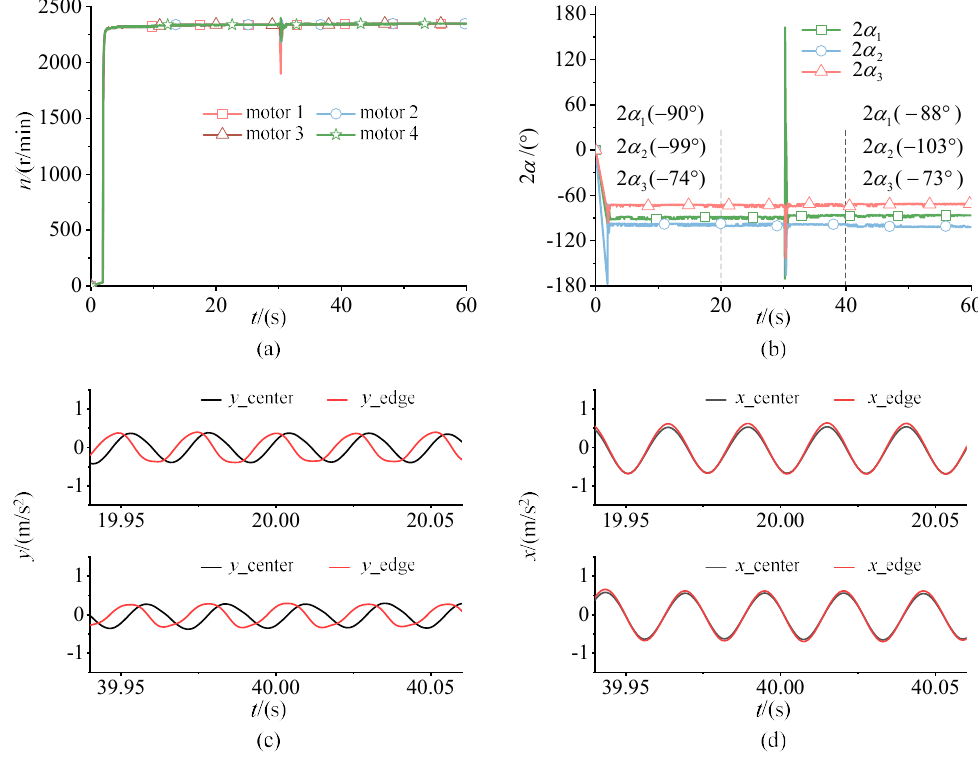
Figure 7. Phase differences of ERs change from 90 ◦ to 90 ◦ with disturbance: ( a ) Synchronous velocities of four ERs; ( b ) Phase differences; ( c ) Acceleration amplitude in y direction at 20 s and 40 s; ( d ) Acceleration amplitude in x direction at 20 s and 40 s.